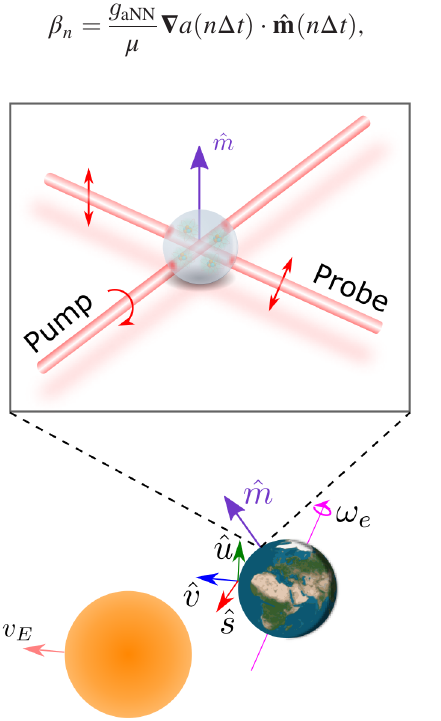
FIG. 1. Schematic showing the sensitive axis ˆ m of the experi- ment as an outward normal from the surface of Earth that rotates at the sidereal frequency ω , leading to sidebands of the axion ’ s e power spectrum. The inset shows a schematic of the comagne- tometer, which consists of spin-polarized atoms in a glass vapor cell that is optically pumped by resonant circularly polarized light and probed by off-resonant linearly polarized light in the horizontal plane. As described in the main text, this implies that the sensitive axis ˆ m is oriented vertically, and by convention, we take it to be the outward normal from the surface of Earth. It is convenient, when deriving the covariance matrix of the axion ’ s frequency spectrum, to use an orthonormal coordinate system f ˆ s; ˆ u; ˆ v g such that ˆ v is parallel to Earth ’ s velocity v E (see Appendix B 1), which is dominated by the Sun ’ s circular